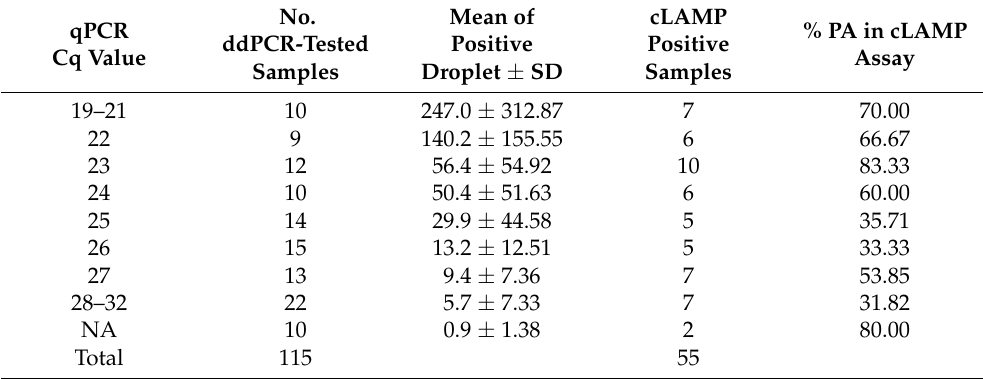
Table 3. Average values (with standard deviation, SD) of positive droplets counted by ddPCR, for olive samples grouped according to similar qPCR Cq values. The number of olive plants positive in the cLAMP assay (and their percentage) are reported, similarly grouped per each Cq value. PA: positive